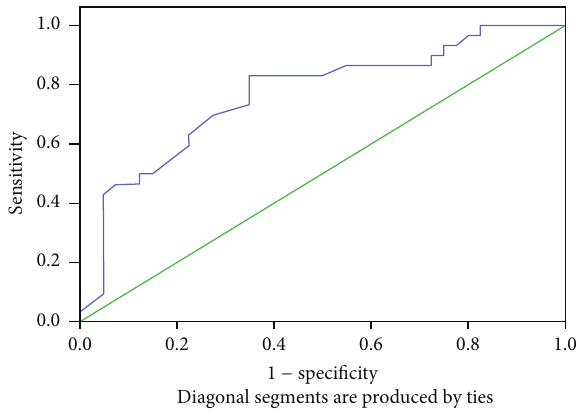
Figure 7: ROC curve area for PNS-P: